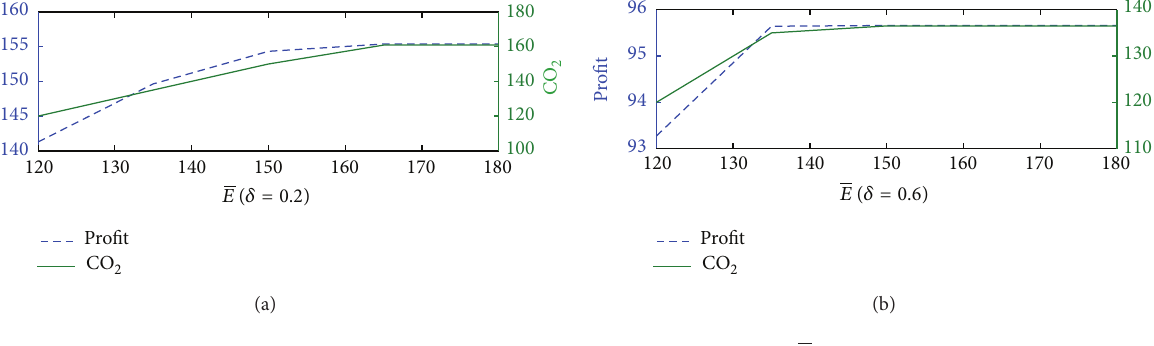
Figure 3: Profit and CO 2 emission with increasing 𝐸 .